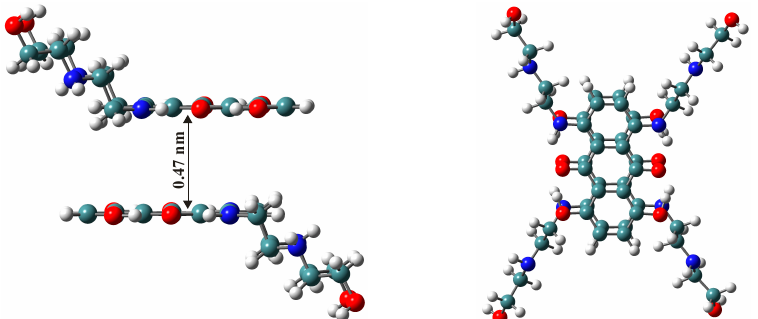
Figure 3. Optimized geometry of mitoxantrone dimer: the side view ( right ) and the perpendicular to the planes of the chromophores view ( left ).